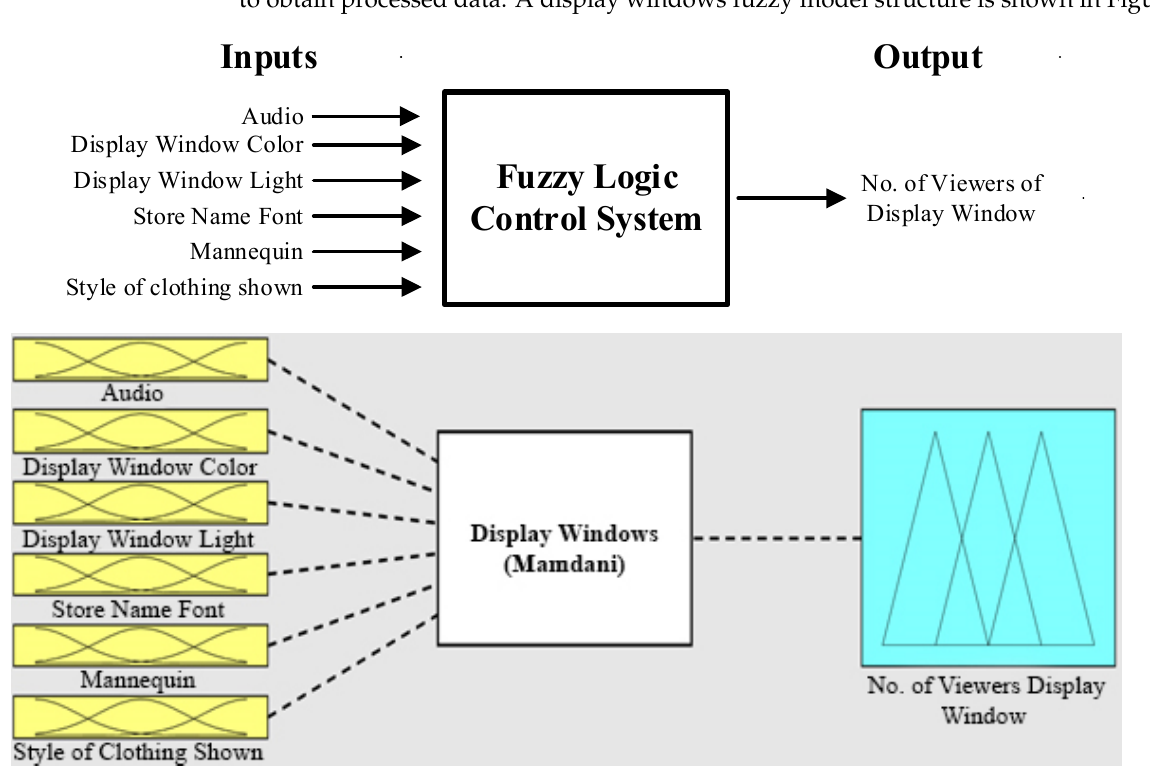
Figure 10. Display window fuzzy system.